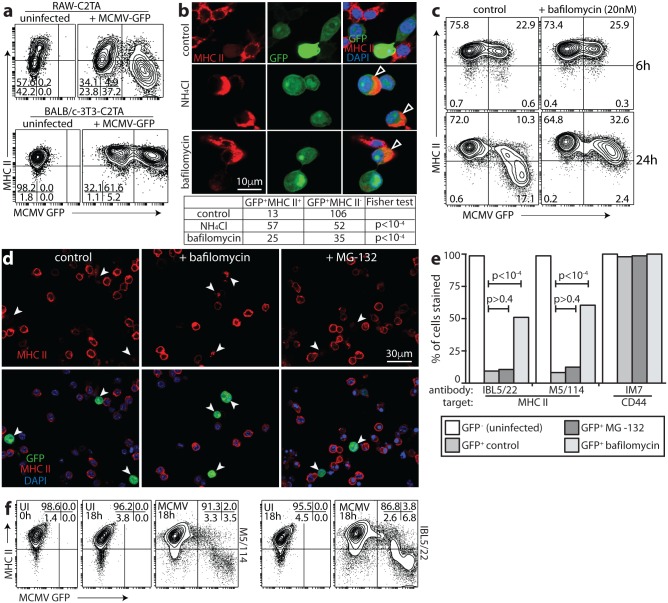
Viral MHC II degradation occurs in low pH endosomes.a. RAW-C2TA and BALB/c-3T3-C2TA cells were infected or not with MCMV-GFP (3 p.f.u. / cell and 0.5 p.f.u. / cell respectively, as MCMV more efficiently infects fibroblasts than RAW-264 cells). 18h later surface MHC II was assayed by flow cytometry. Unlike RAW-C2TA macrophages, infected 3T3-C2TA fibroblasts retained MHC II expression. b. RAW-C2TA cells infected or not with MCMV-GFP (1 p.f.u. / cell, 24h) were exposed (18h) to 100mM ammonium choride, 20nM bafilomycin or medium alone (control), then fixed, permeabilized and stained for MHC II. Viral GFP was visualized directly. Nuclei were stained with DAPI. Arrows show cells with rescued MHC II. The table quantitates MHC II expression for GFP+ cells. c. RAW-C2TA cells were infected with MCMV-GFP (3 p.f.u. / cell, 2h). Then bafilomycin (20nM) was added or not (control), and the cells cultured for a further 6h or 24h. They were then stained for MHC II with Alexa647-conjugated mAb M5/114 and analysed by flow cytometry. Virus-expressed GFP was assayed directly. Numbers show the % of total cells in each quadrant. d. RAW-C2TA cells were infected with MCMV-GFP (1 p.f.u. / cell, 72h), treated with bafilomycin (20nM) or the proteasome inhibitor MG-132 (50μM), and 18h later stained for MHC II. Arrows show example infected cells. The MHC II rescued by bafilomycin had an endosomal distribution. MG-132 gave no rescue. Representative images are shown. e. Total cell counts across at least 10 fields of view are shown for cells as illustrated in d (>200 cells per bar). Statistical comparison was by Fisher’s exact test. f. RAW-C2TA cells were incubated (1h, 37°C) with M5/114 or IBL5/22 rat mAbs to MHC II, washed to remove unbound antibody, infected (MCMV, 18h) or not (UI, 18h) with MCMV-GFP (2 p.f.u. / cell), cultured overnight (18h, 37°C), stained at 4°C with anti-rat IgG pAb and analysed by flow cytometry. Control untreated cells (UI, 0h) were stained in parallel for surface MHC II using M5/114 and anti-rat IgG pAb without overnight culture.